Question: Generate an informative caption for the figure above.
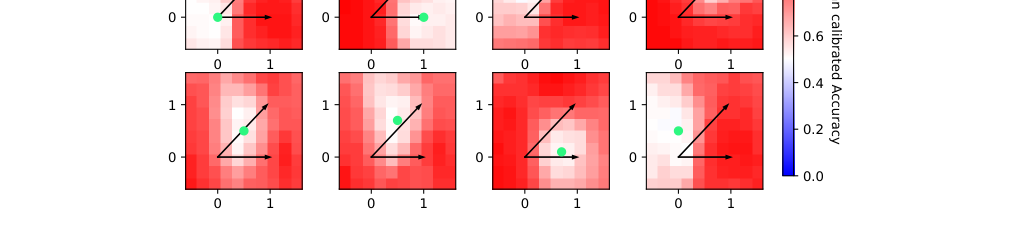
Answer: The plots show the mean median-calibrated accuracy when one pair of binding ID, v0, is fixed at the green circle, and the other, v1, is varied across the grid. The binding IDs b(0), b(1), and b(2) are shown as the origin of the arrows, the end of the horizontal arrow, and the end of the diagonal arrow respectively. We use LLaMA-13b for computational reasons.